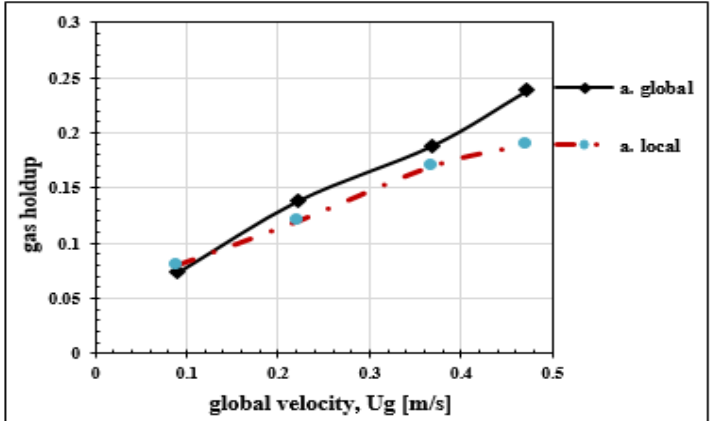
Figure 17. Relationship between global and local gas holdup with superficial gas